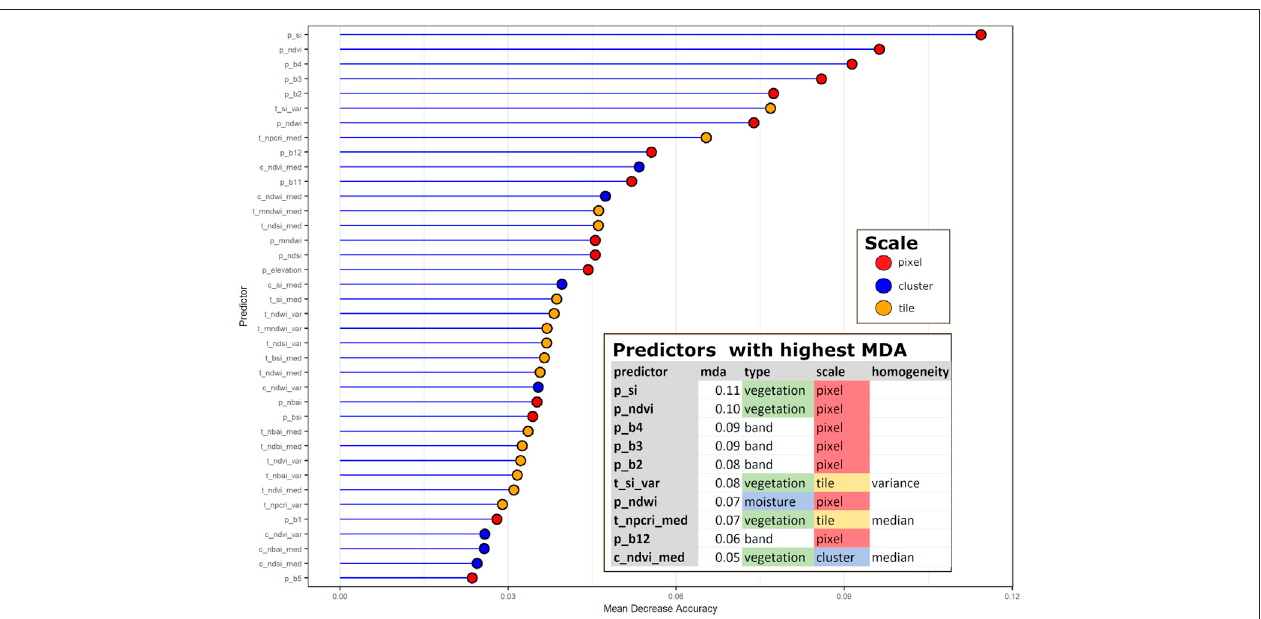
FIGURE 10 | Mean Decrease Accuarcy measures each predictor ’ s in fl uence on the LULC classes simulated by the Random Forest Model. Each predictor has three attributes: type, scale, and homogeneity. Type refers to how they are used (e.g., to detect vegetation, water, etc.). Scale is the spatial level at which each was measured. Homogeneity is the median or variance of each raster index at the cluster or tile levels. The most in fl uential predictors are shown inset. They are a mix of predictors varying by type, scale and homogeneity.